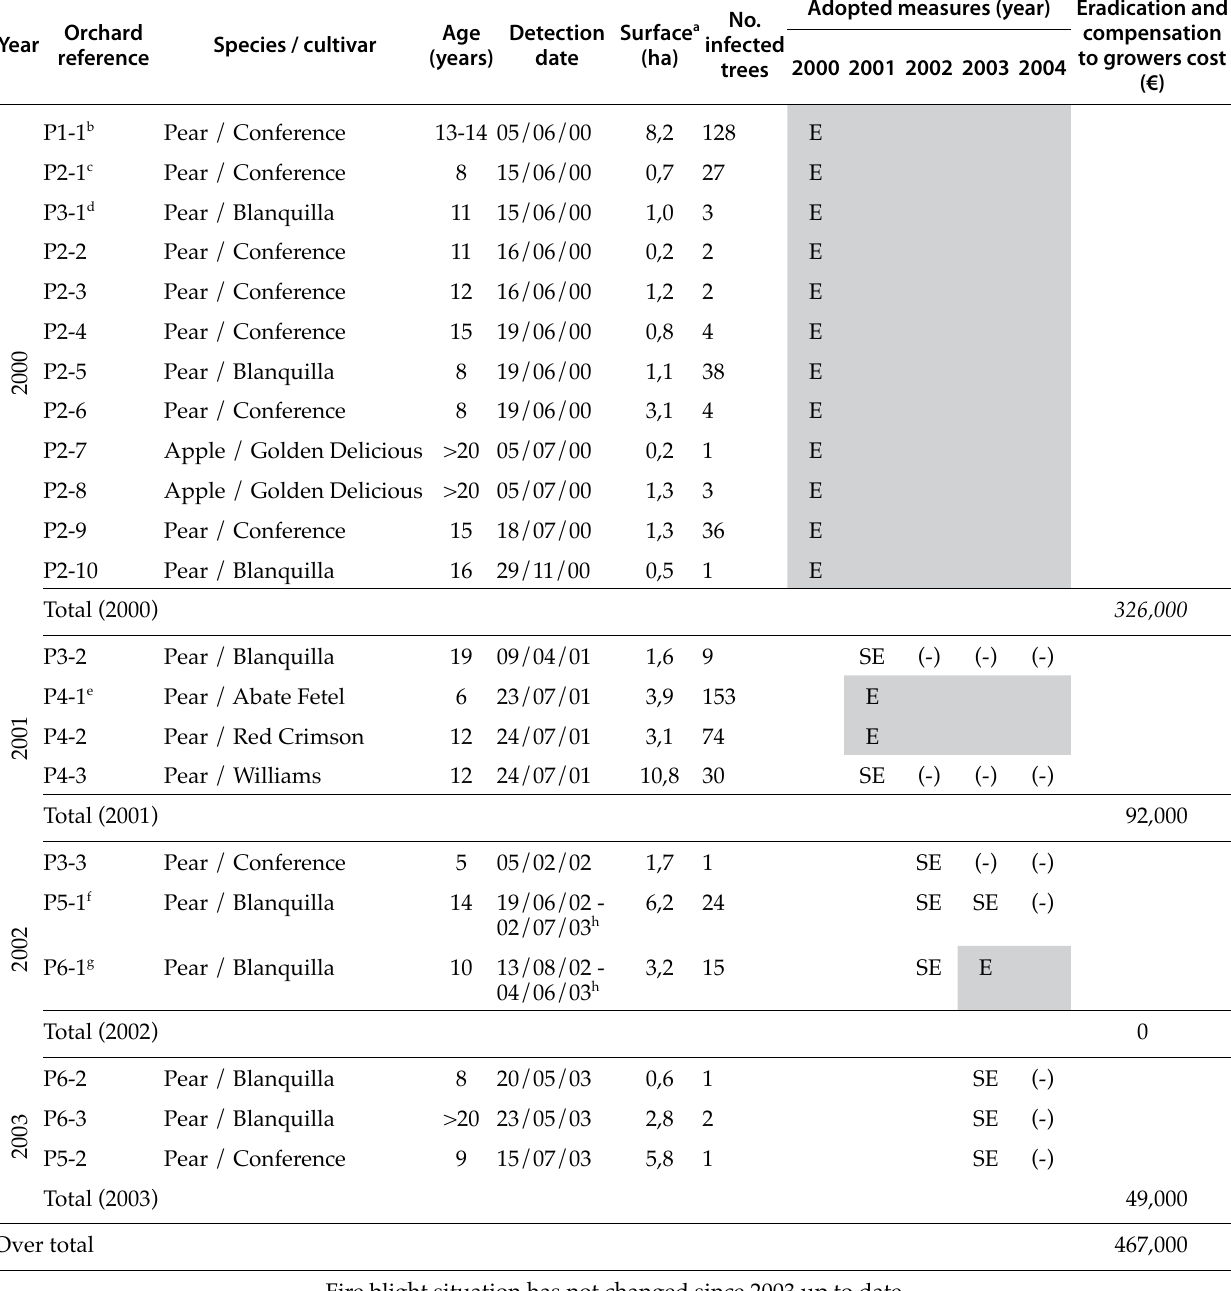
Table 2. Orchards identified in mid Jalón river area (mid Ebro Valley) of Zaragoza (Spain) with trees affected by fire blight in 2000-2003, type of eradication adopted and estimated cost of eradication and compensations to